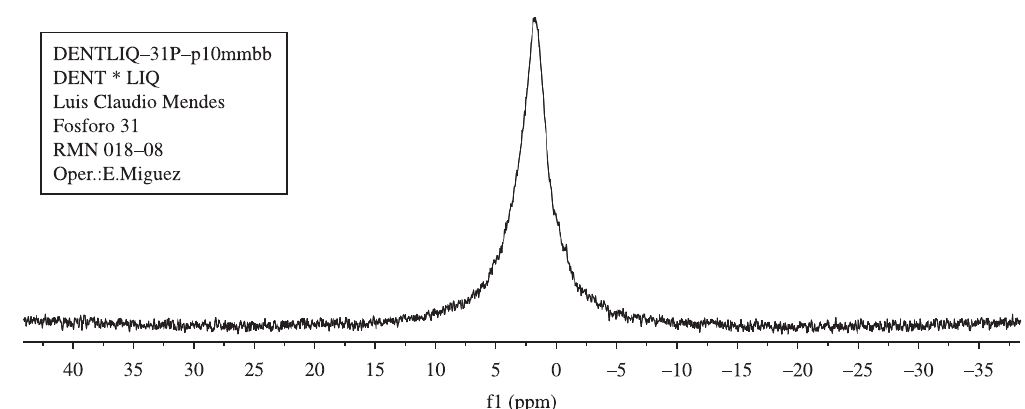
Figure 3. 31 P NMR spectrum of the cement liquid portion.